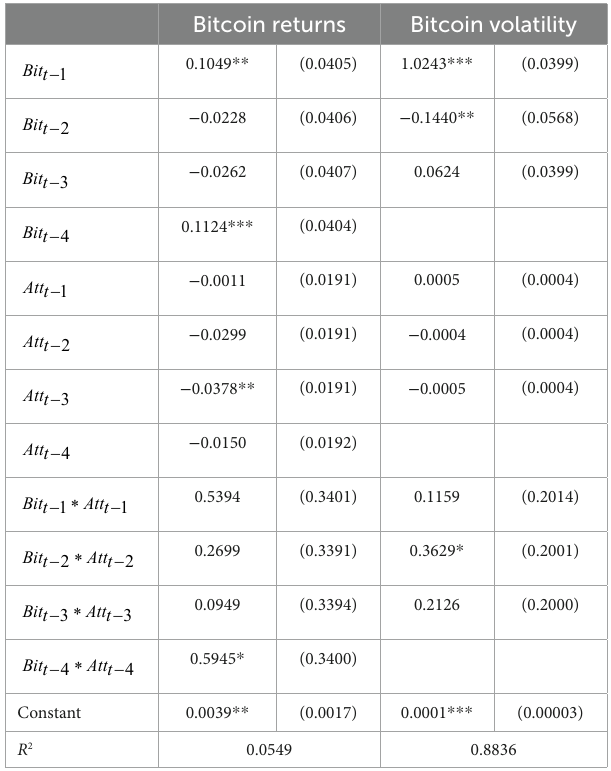
TABLE 4 The estimation results of the interactive